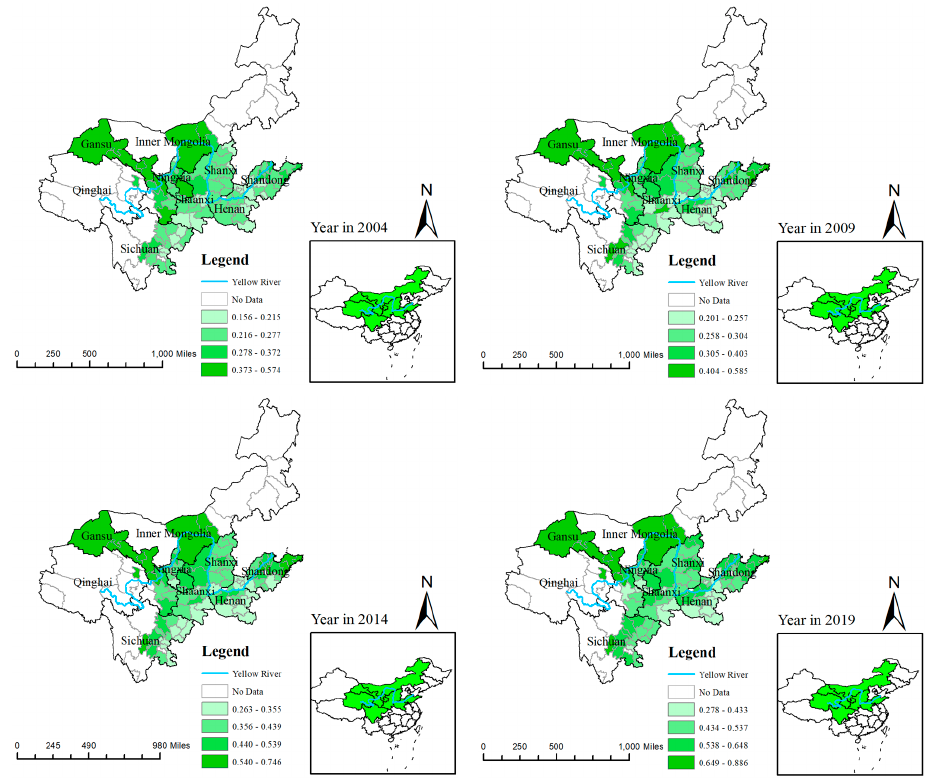
Figure 2. The spatial distribution map of ECP in YRB over the years in nine provinces. Comparing the spatial distribution in 2004 and 2019, the index of ECP in medium- stream and downstream of YRB in 2019 was higher than that in 2004, such as the cities in Shandong, Henan, Sanxi, Sichuan, and the minimum and maximum value in 2019 are higher than that in 2004, 2009, or 2014. This indicates that the whole level of ECP is constantly improving under the concept of ecological civilization in the road of common prosperity. 4.2. Evolution Trend of ECP in the YRB In order to reveal and analysis the evolution trend of ECP in the YRB during the inspection period, this paper calculates the index level of ECP in 97 prefecture-level cities of YRB from 2003 to 2019 based on the entropy method. The average level of ECP in the whole area of YRB, and average level in areas of upstream, medium-stream, and downstream are shown in ; it shows the evolution trend of ECP in the YRB from 2003 to 2019.